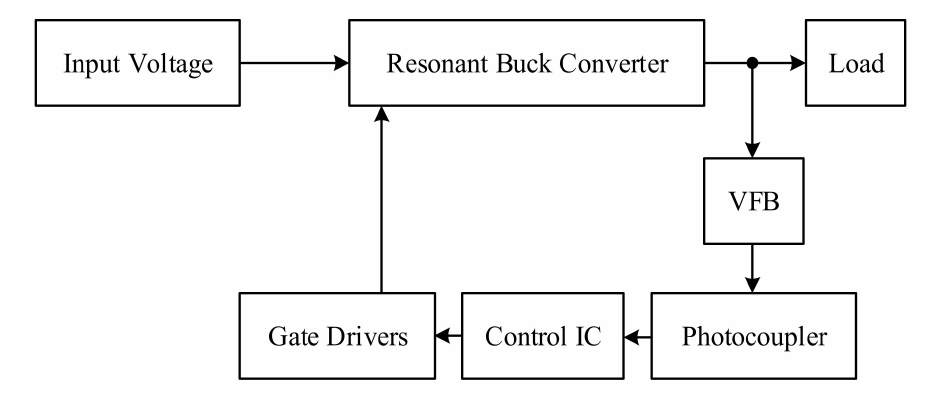
Figure 9. System configuration block diagram.